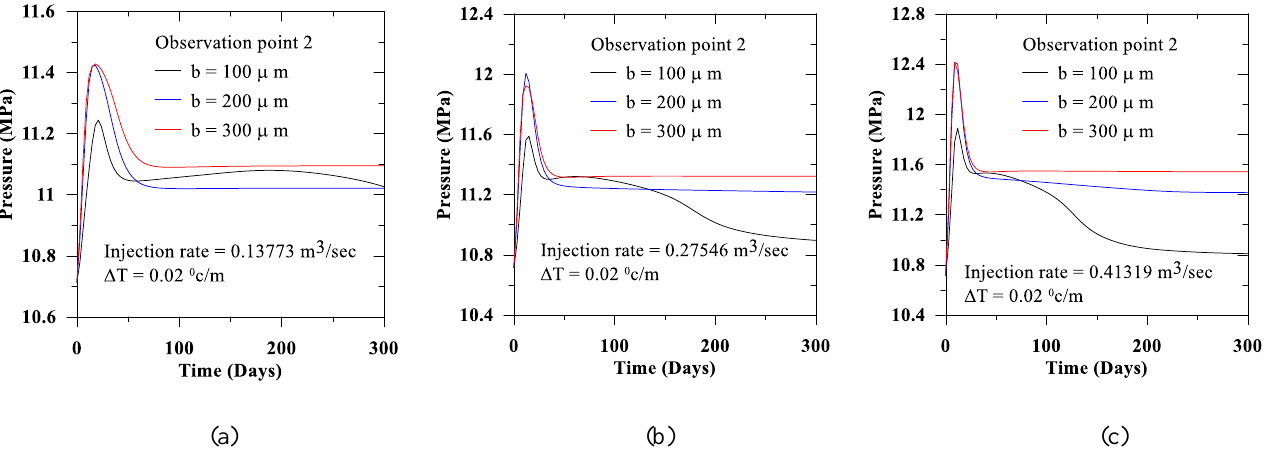
Figure 11. The pressure distribution ( a – c ) in observation point 1.